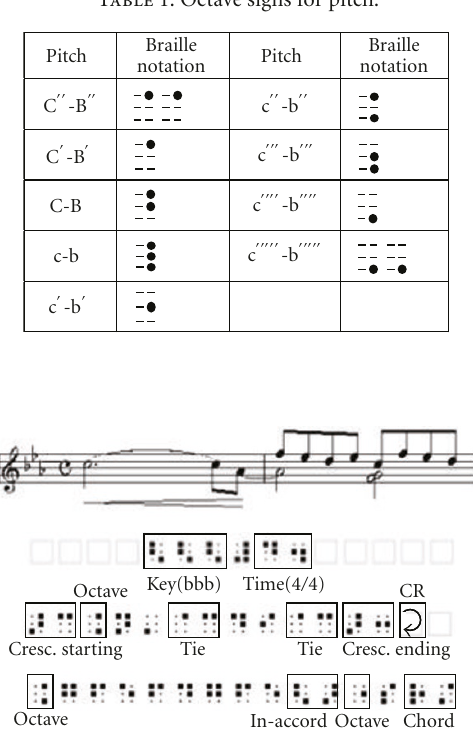
Figure 2: A sample of a Braille music